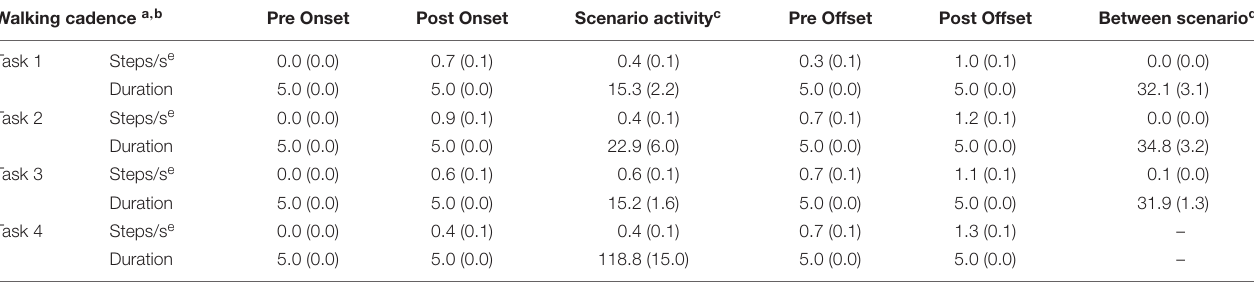
TABLE 2 | Physical activity. Walking cadence a , b